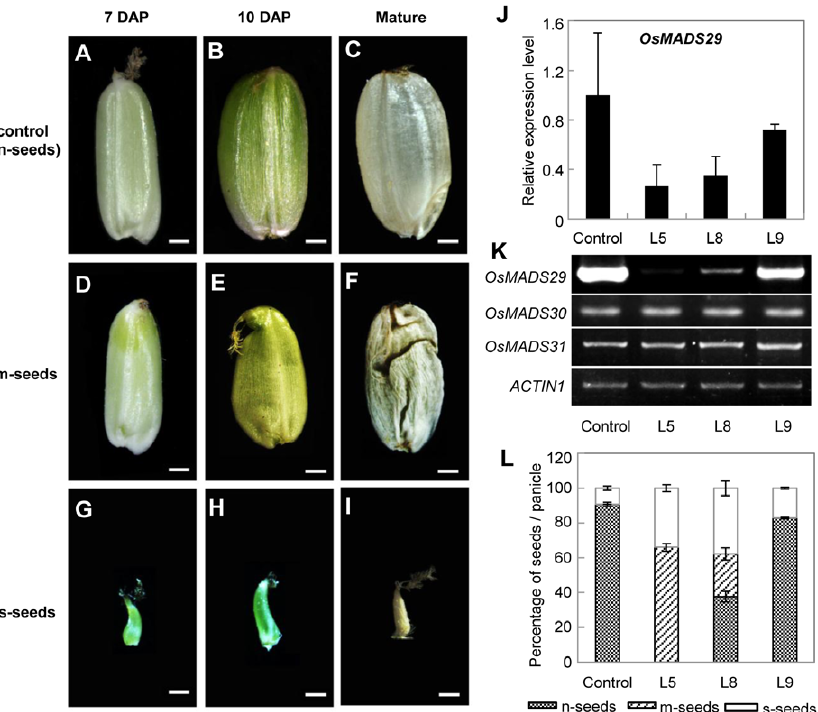
Figure 3. Phenotypes of OsMADS29 RNAi lines and molecular detections. (A–I). Profiles of seeds at 7 DAP, 10 DAP and mature stages, respectively. (A–C), n-seeds of control plants. (D–F), m-seeds with deficient starch accumulation in the endosperm. (G–I), s-seeds that are aborted before 7 DAP. Bars=1 mm. (J). Relative expression levels of OsMADS29 in control plants and three typical OsMADS29 RNAi lines (L5, L8 and L9). Total RNA was pooled from stage Ov10 [48]. The ACTIN1 was used as the internal control. Error bars show SD (n=3). (K). RT-PCR analyses of OsMADS29 and the other two related B sister genes of rice, OsMADS30 and OsMADS31 , in control plants and RNAi plants. Total RNA was pooled from stage Ov10. The ACTIN1 was used as the internal control. (L). Percentage of different kinds of seeds in one panicle in control plants and different OsMADS29 RNAi lines. The error bar indicates the SE (n=3).